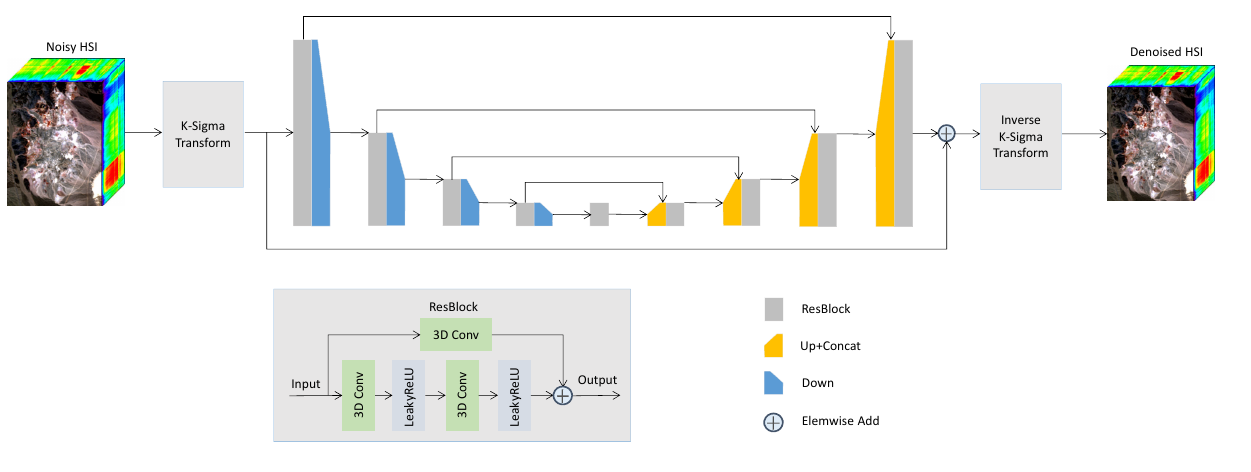
Figure 4. The overall structure of the KST-based denoising